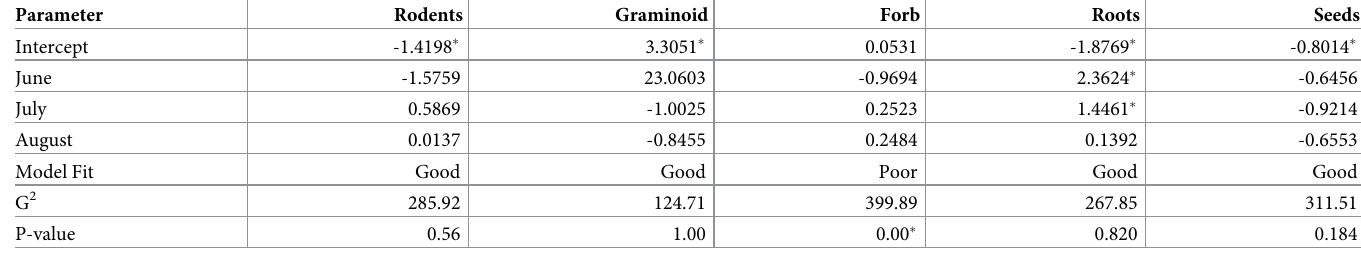
Table 3. Parameter estimates of logistic regression models of the temporal effect on major diet categories of brown bears in Deosai National Park, Pakistan. Sep- tember was set as the base redundant parameter.